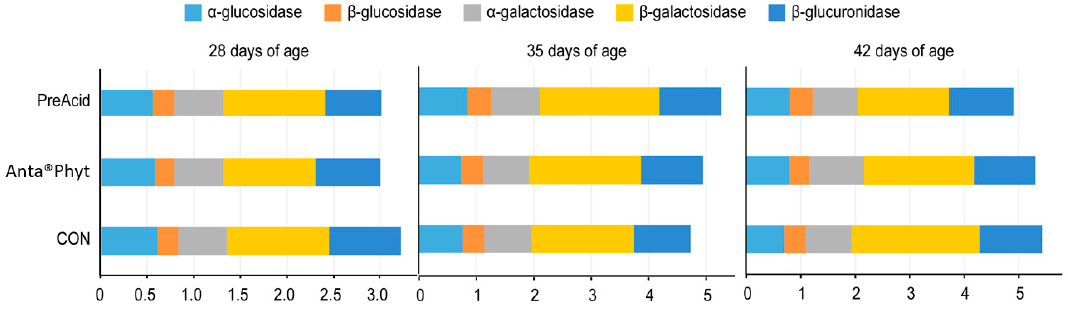
Figure 2. The effect of dietary treatments on the bacterial enzyme activities (µmol/h/g) in the cecal digesta of chickens at days 28, 35 and 42 of age. Birds were fed a control diet (CON); the control diet supplemented (on top) with phytogenic ingredients from hops, licorice and arabic gum (Anta ® Phyt); or a diet supplemented with a mixture of a free butyrate acidifier and prebiotic gluconic acid (PreAcid). Data are the means of 12 replicates per treatment. Differences between groups were considered significant when p < 0.05.